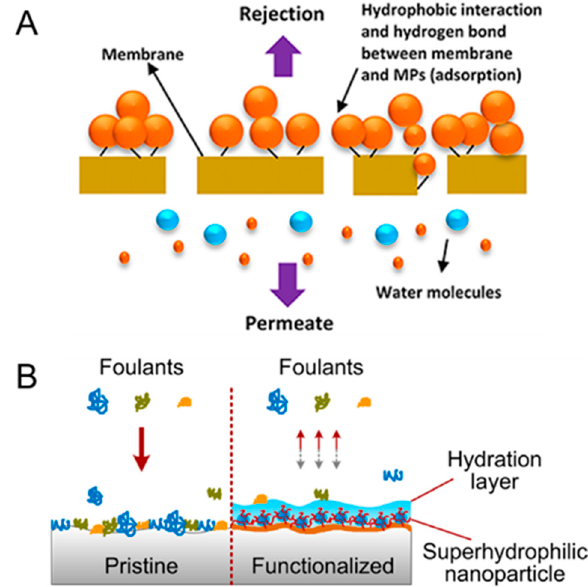
Figure 5. ( A ) Schematic illustration of the removal mechanism of micropollutants in porous membranes [62]. The micropollutants are preferentially adsorbed onto the membrane because of hydrophobic interaction with the membrane surface, whereas water molecules readily permeate through the membrane pores. ( B ) Schematic illustration of foulant adsorption on a pristine membrane and a functionalized membrane with a hydration layer on the membrane surface [63]. The hydration layer is formed due to the presence of hydrophilic filler materials. The hydration layer inhibits foulant adsorption, thereby reducing the propensity of membrane fouling. All figures are reprinted with copyright permissions from the respective references.